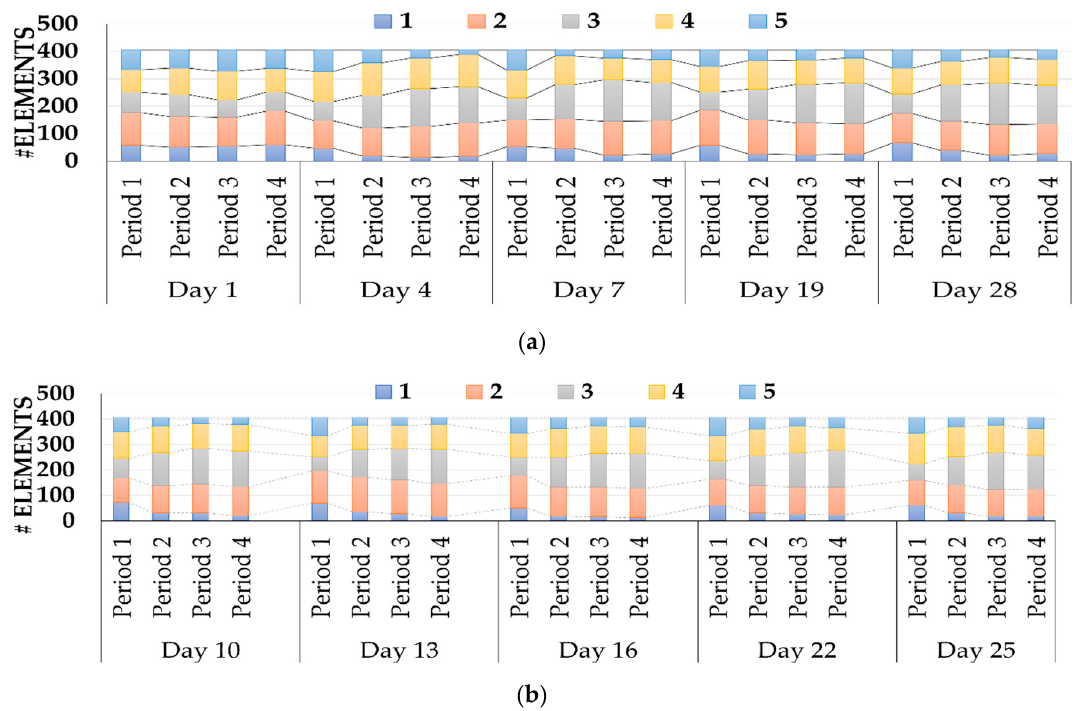
Figure 5. Number of elements per Reliability Rate group considering the final rate being: ( a ) DR event 1; ( b ) DR event 2.